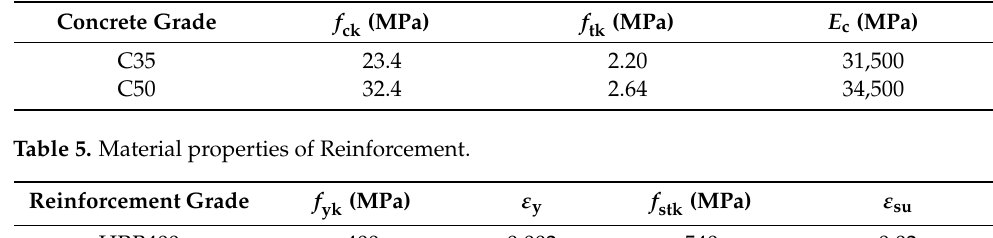
Table 4. Material properties of concrete.